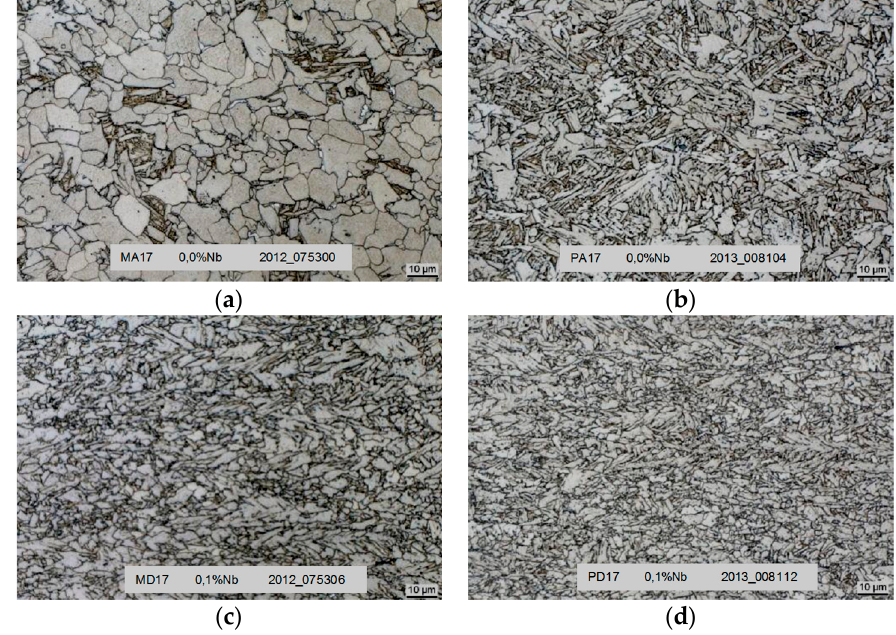
Figure 3. Light optical micrographs (Le Pera etching) of the as-rolled materials: ( a ) V2-a (polygonal ferrite); ( b ) V2-d (mostly acicular ferrite); ( c ) V4-a (coarse acicular ferrite); ( d ) V4-d (fine acicular ferrite).